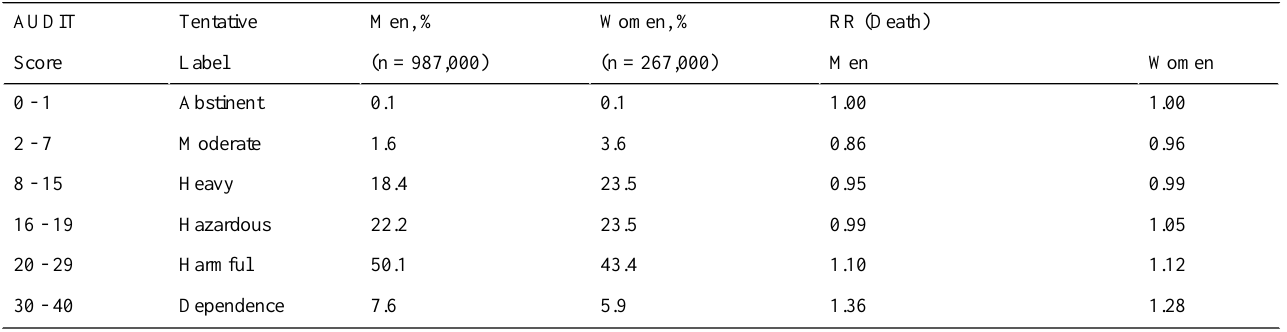
Table 4. Preintervention characteristics of the target population